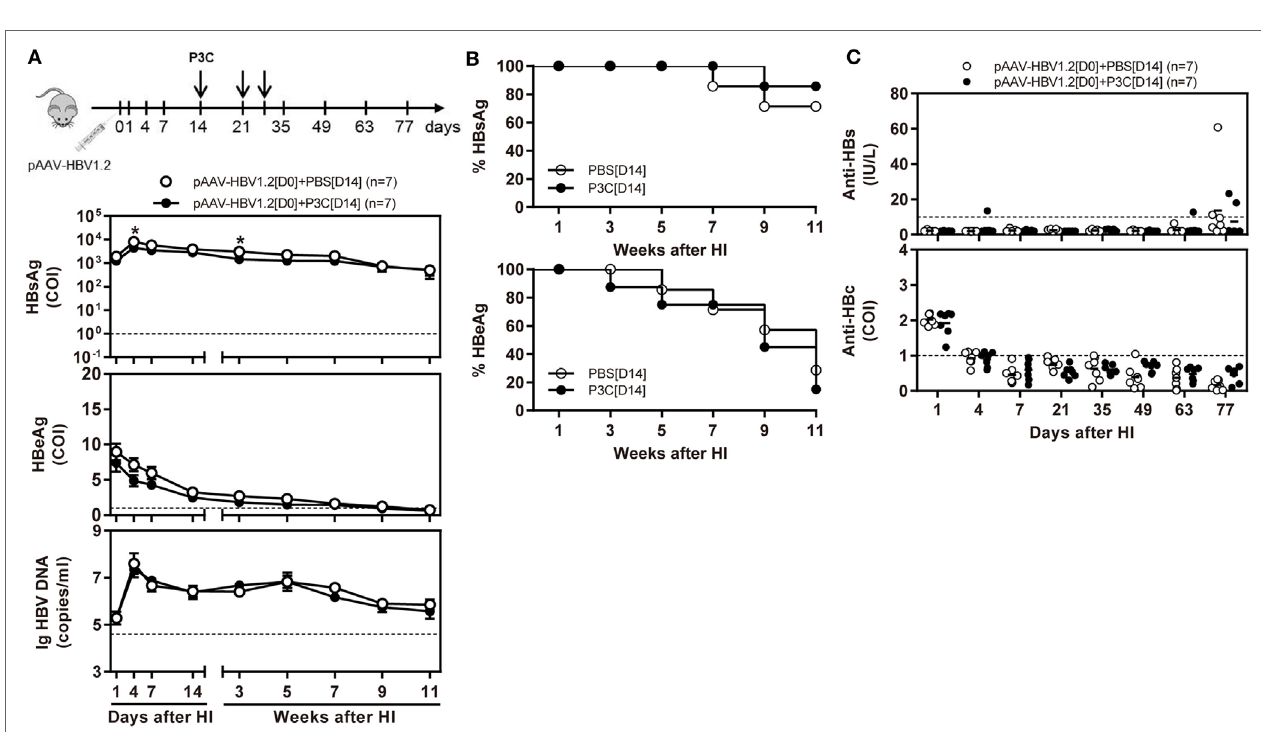
FigUre 3 | Application of toll-like receptor 2 ligand P3C at a late time point after hydrodynamic injection (HI) does not inhibit hepatitis B virus (HBV) replication in the model for persistent HBV replication. C57BL/6 mice received (HI) with plasmid pAAV-HBV1.2. These mice were then treated three times with 50 µg of P3C or phosphate-buffered saline administered by subcutaneous (SC) injection at day 14, 21, and 28 (D14). (a) Serological markers of HBV infection HBsAg, Hepatitis B e antigen (HBeAg), and HBV DNA were assayed at the indicated time points. (B) Positivity for HBsAg or HBeAg was defined as ≥ 1. (c) The serum levels of anti-HBs and anti-HBc antibodies were also detected at the indicated time points. Seven mice were analyzed per group, and the experiments were repeated at least once. Data were analyzed using an unpaired Student’s t test. Statistically significant differences between the groups are indicated as * P < 0.05 and ** P < 0.01.